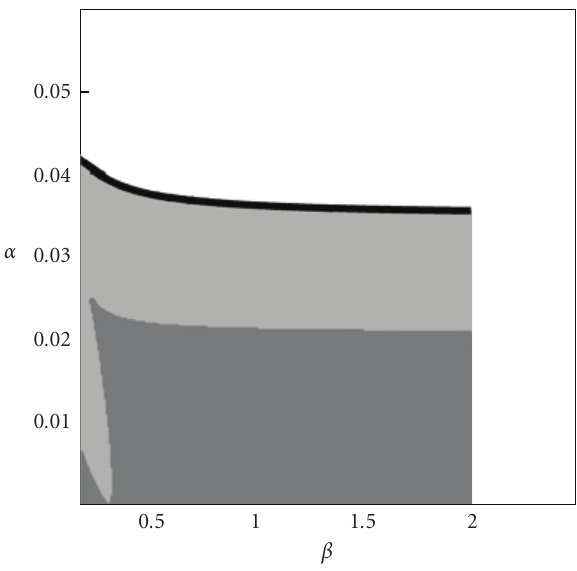
Figure 3.1. Region of stability of the equilibrium and the Hopf-Neimark bifurcation curve (bold) in the ( β , α ) parameter